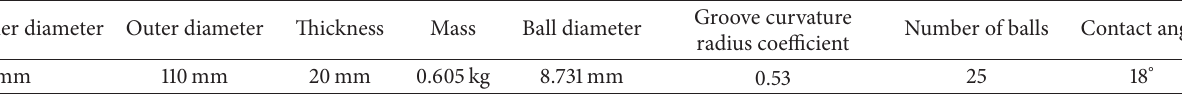
Figure 8: Sketch of the SBS. Table 1: Basic parameters of